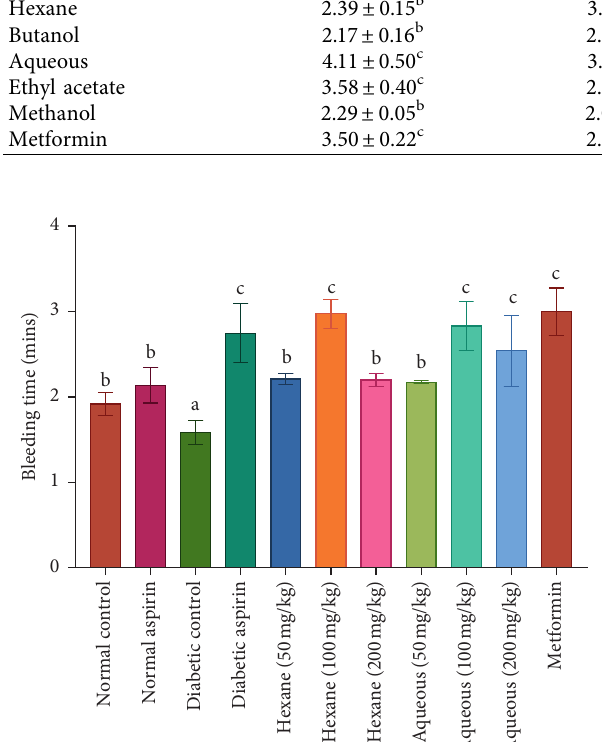
Figure 1: Bleeding time in diabetic rats treated with different concentrations of aqueous and hexane fractions of C. crepidioides b and c are significantly higher than a ( P < 0 . 05). c is significantly higher than b at P < 0 . 05; n �